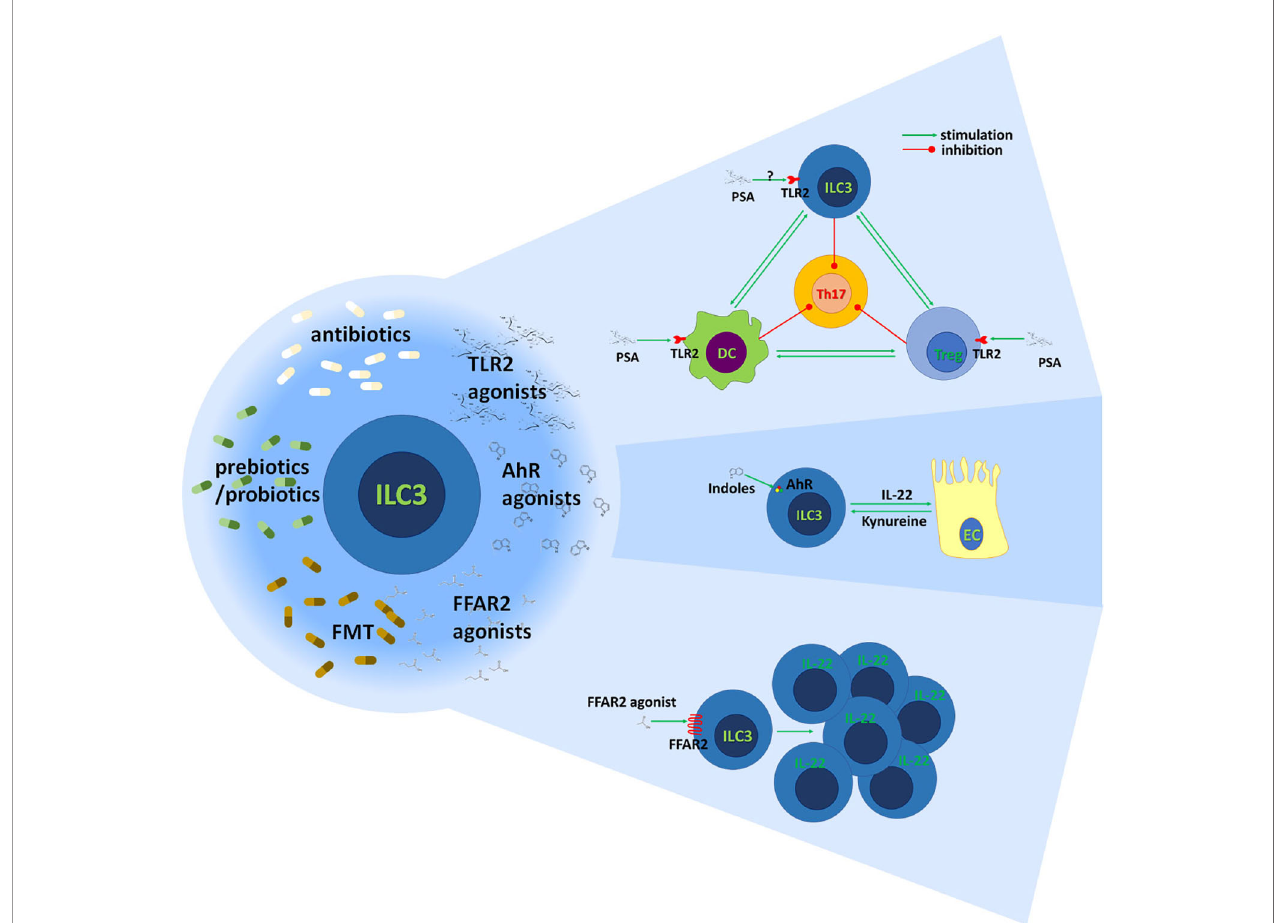
FIGURE 4 | Stimulation of gut ILC3 for the bene fi t of MS patients. The immunoregulatory activity of gut ILC3 could be achieved through modulation of gut microbiota by antibiotics, prebiotics or probiotics, and fecal microbiota transfer (FMT). Also, it can be potentiated through agonists of TLR2, AhR, and FFAR2. It is known that polysaccharide A (PSA) acts through TLR2 on Treg and DC to inhibit encephalitogenic Th17 cells. Also, it is established that ILC3 potentiate tolerogenic DC properties and stimulate Treg functions. It remains to be determined if PSA acts on ILC3 through TLR2 and if it contributes to ILC3-imposed immunoregulation in the gut. Indole derivates of food and gut microbiota and kynurenine produced by gut epithelial cells (EC) stimulate ILC3 through AhR to generate IL-22. IL-22 has multiple bene fi cial effects on epithelial cells and the intestinal barrier. FFAR2 agonists promote the proliferation of IL-22-producing ILC3 acting through